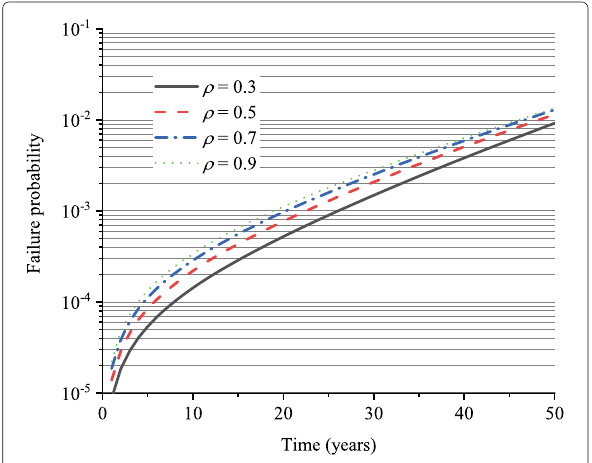
Fig. 10 Dependence of failure probability of a 4-out-of-5 system on component resistance correlation ( ρ